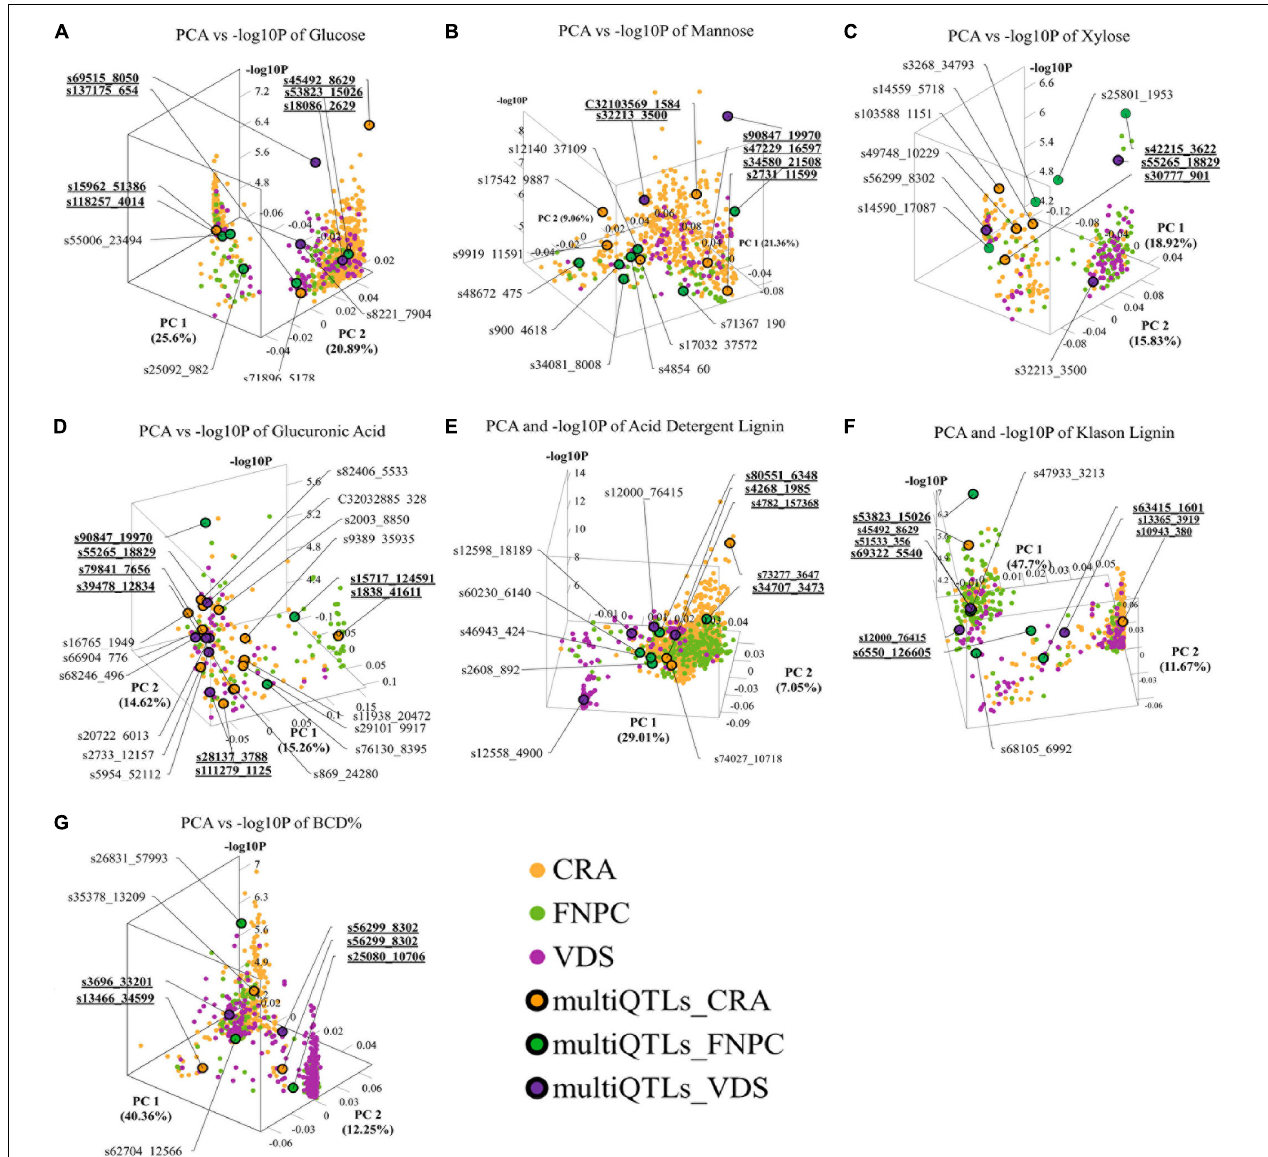
FIGURE 4 | 3D scatter plots of principal component analyses (PCAs), depicting variation in the allele frequency profiles of significant loci for respectively contents of glucose (A) , mannose (B) , xylose (C) , glucuronic acid (D) , acid detergent lignin (ADL; E ), Klason lignin (KL; F ), and bast fiber content after decortication (BCD; G ). The plots resemble the peak tops of the quantitative trait loci (QTLs) in Manhattan plot distributions, despite the lack of physical positions on a chromosome. Each dot represents a significant QTL-marker (loci). X -axes = principal component 1 (PC1) with the percentage of explained variance; Y -axes = principal component 2 (PC2) with the percentage of explained variance; Z -axes = significant levels of the loci in the genome-wide association study (GWAS) association (-log 10 P ); Orange, green, and purple dots = significant QTL-markers detected in respectively Centro di ricerca cerealicoltura e colture industriale (CRA), Fédération Nationale des Producteurs de Chanvre (FNPC), and Vandinter Semo BV (VDS); Orange, green, and purple dots with a black circle = representative QTL-markers of the MultiQTL models from respectively CRA, FNPC, and VDS; CRA = field trial in Italy; FNPC = field trial in France; VDS = field trial in Netherlands; QTL-names (e.g., s55006_23495) = QTL-markers from different MultiQTLs models; QTL-names in bold and underlined (e.g., s69515_8050 ) = QTL-markers from different MultiQTLs models that belong to a QTL region across locations. Each plot is shown in the angle that represents better the results. Principal Components and -log 10 P for each loci can be found in Supplementary File 1